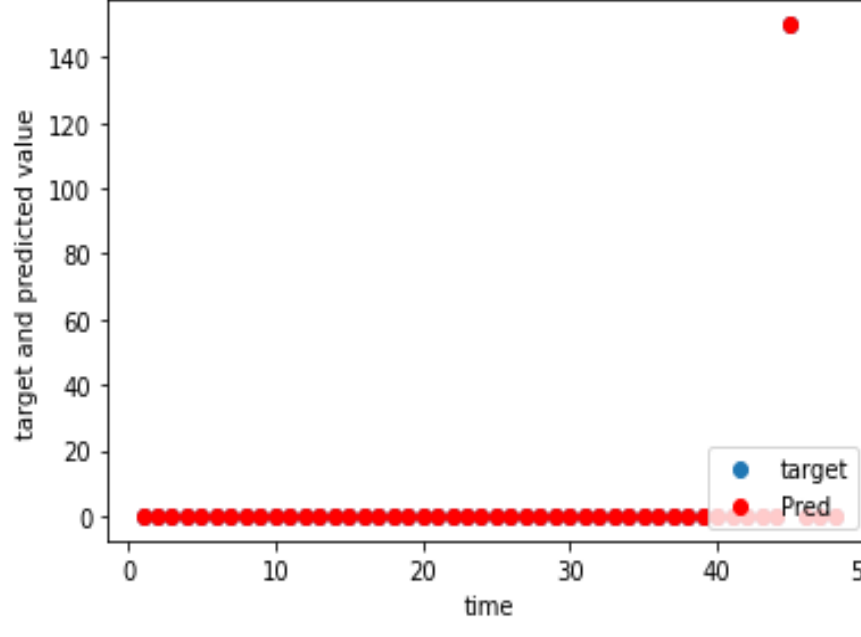
Figure 12. Charging demand prediction of a weekend for Munkkiranta.